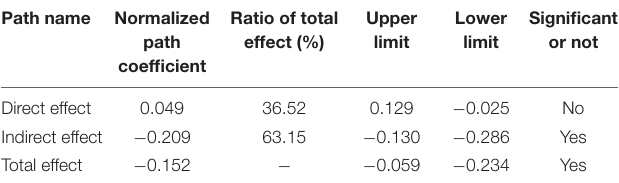
TABLE 12 | Path analysis